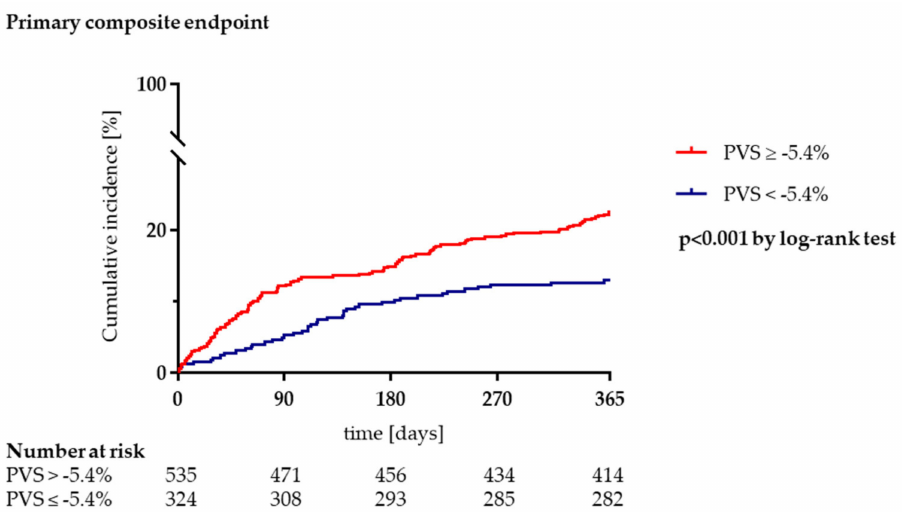
Figure 1. Elevated plasma volume status (PVS) is associated with the primary composite endpoint of all-cause mortality or heart failure hospitalization after transcatheter aortic valve implantation. Leg- end: Kaplan-Meier survival curves for the primary endpoint comparing patients with a PVS ≥ − 5.4% (congestion) to patients with a PVS < − 5.4% (no congestion).